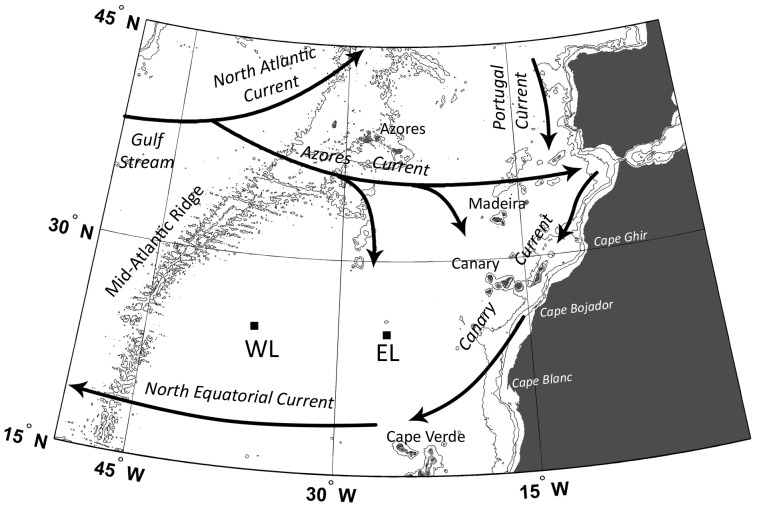
Map showing the study area and the location of the surveys.Two Lagrangian surveys were conducted during the CARPOS cruise near the center of the subtropical gyre, i.e. the West Lagrangian (WL), and near the eastern boundary, i.e. the East Lagrangian (EL).